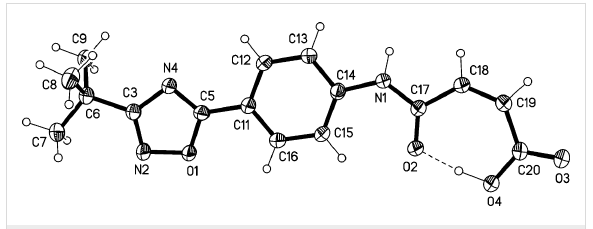
Figure 10: Molecular structure of ( Z )-4-(4-(3- tert -butyl-1,2,4-oxadiazol- 5-yl)phenylamino)-4-oxobut-2-enoic acid ( 6 ). Atoms are drawn as 50% thermal